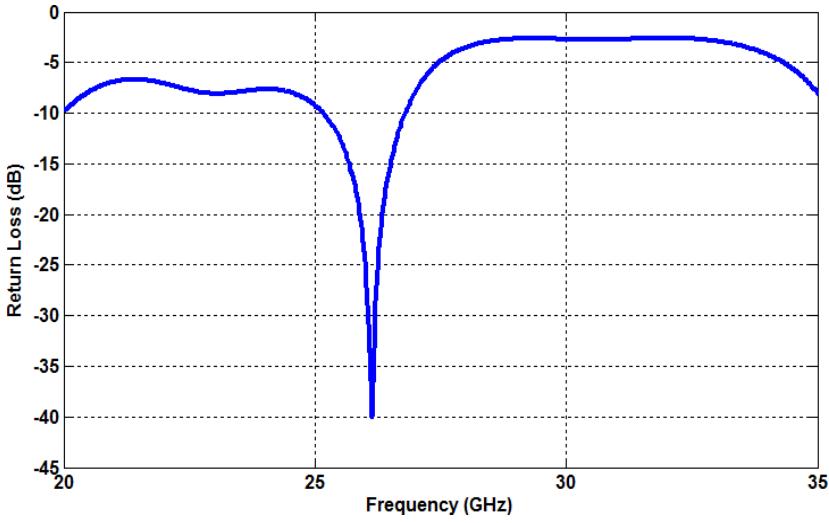
Figure 4. Simulated return loss (S11) for proposed antenna.